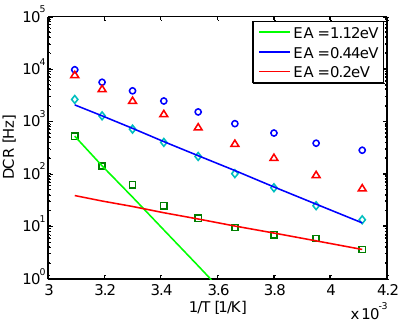
Figure 3. DCR temperature dependence for 10-μm diameter SPADs in 150 nm standard CMOS.